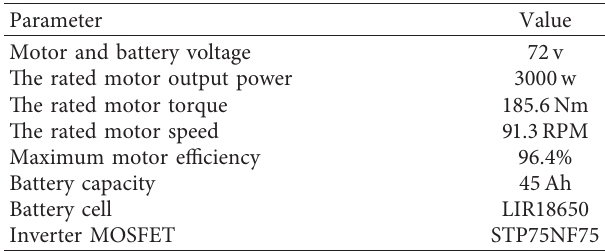
Table 2: Electrical characteristics.